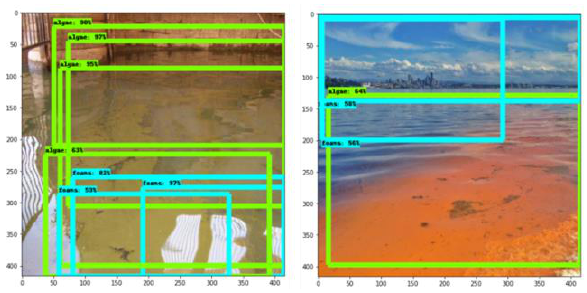
Figure 9. True positives for algae and false positive for foams (reflection of light, left and clouds, right)